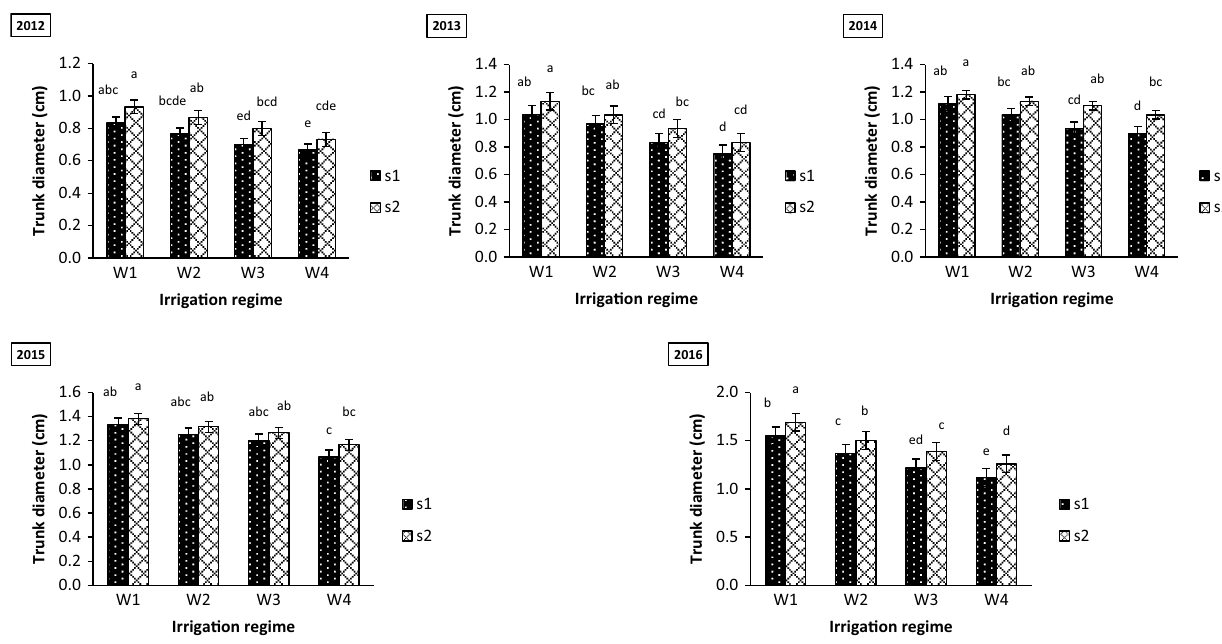
Fig. 3 Interactive effect of volcanic tuff and irrigation regime on trunk diameter of olive tree through the 5 years